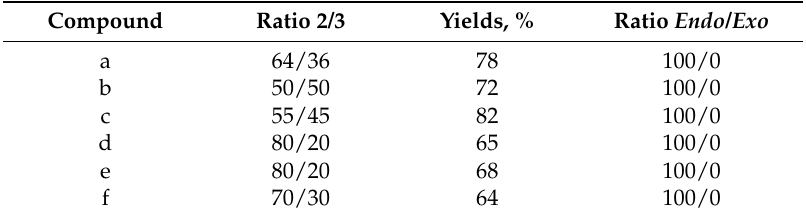
Table 1. Yields and isomer ratios of compounds 2 and 3 .